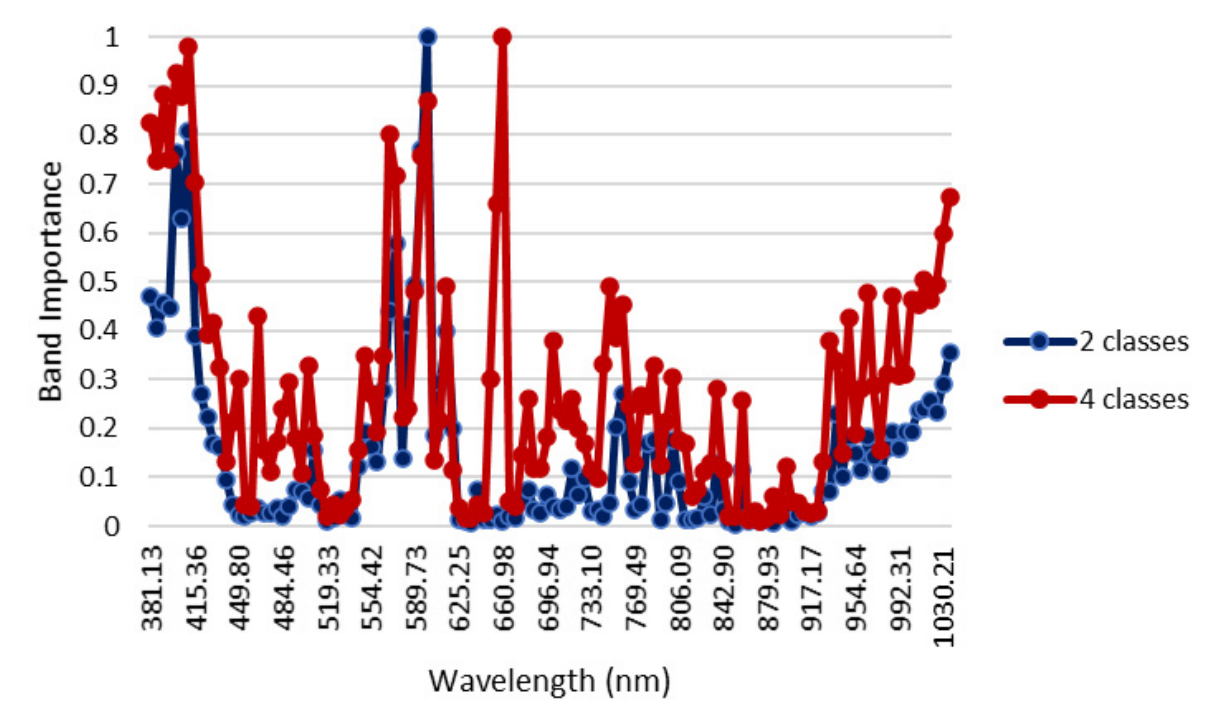
Figure 15. Band importance determined by XGBoost on the maximum tuberization phenological stage.